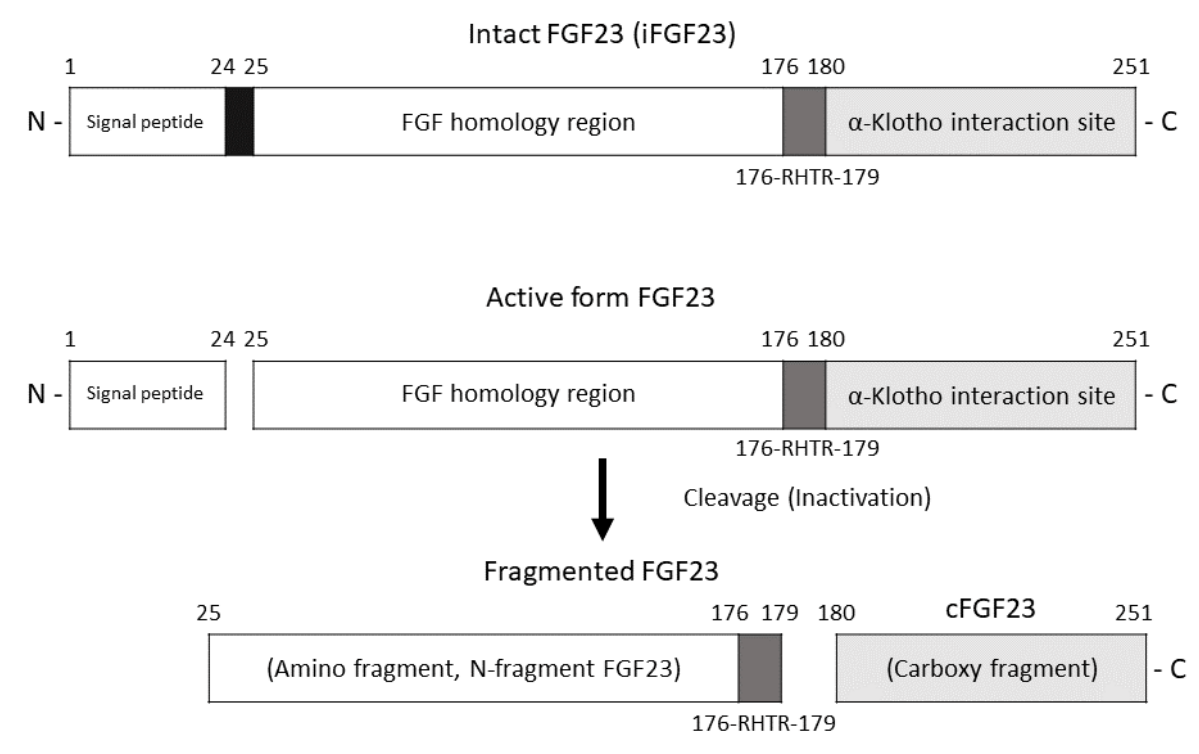
Figure 1. Structures of iFGF23 and cFGF23. iFGF23 protein is cleaved into an amino fragment (N-fragment FGF23, 18 kDa) and a carboxy-terminal fragment (cFGF23, 12 kDa). Note that 176-RHTR-179 represents the amino sequence of 176Arg-His-Thr-Arg179, which is the furin cleavage site.